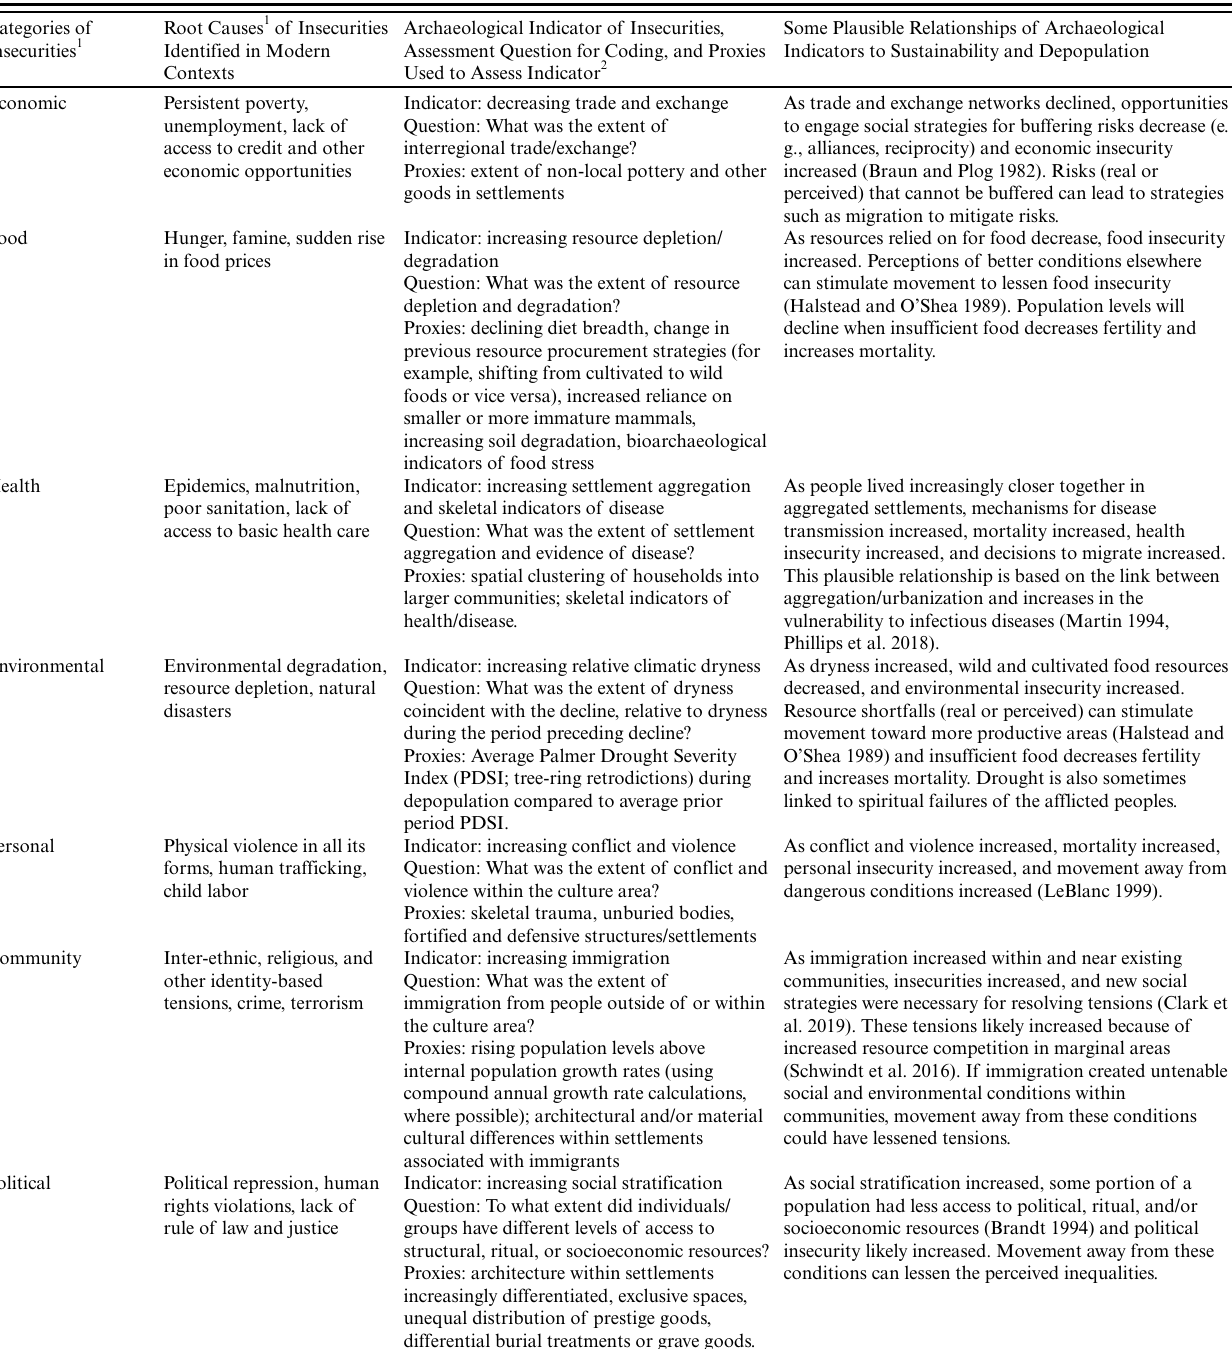
Table 2 . Human insecurities, archaeological indicators and proxies, and plausible relationships to sustainability and depopulation. Categories of Insecurities